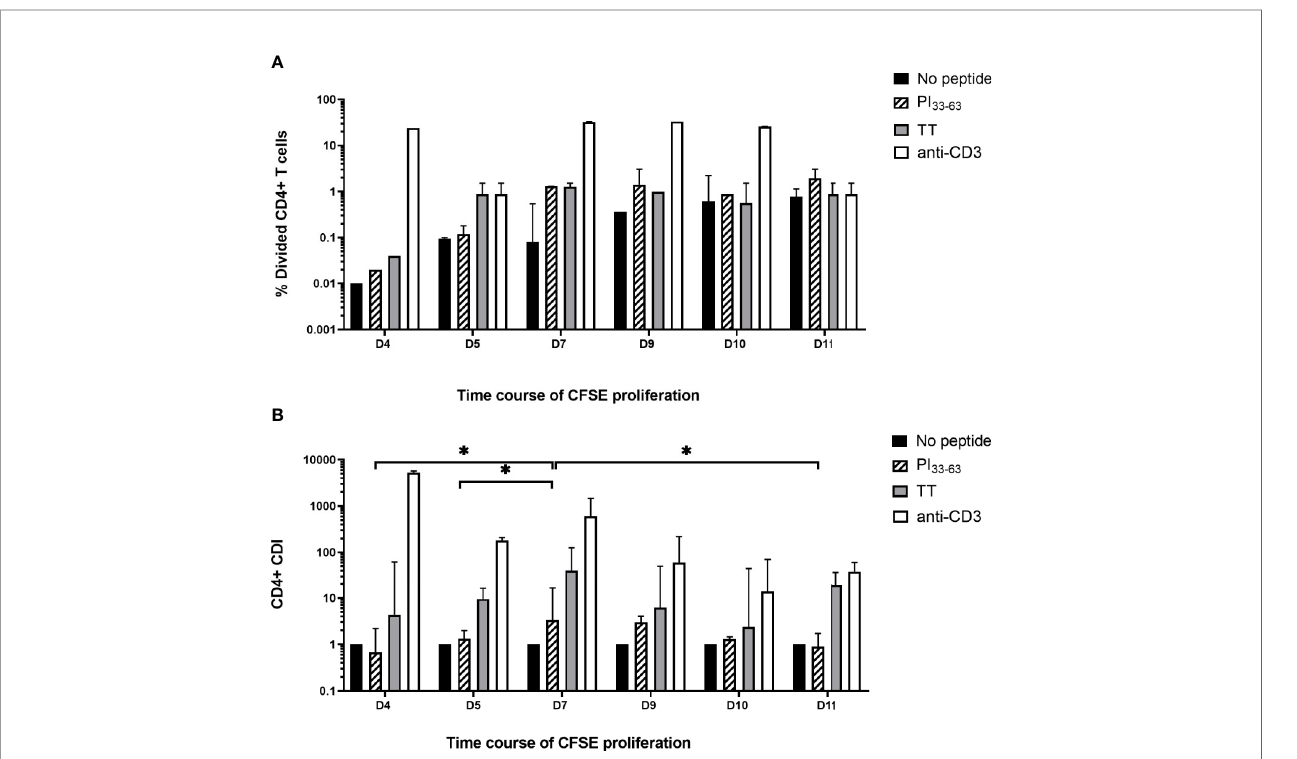
FIGURE 4 | Time course of CFSE proliferation assay. Freshly isolated PBMC labeled with CFSE 0.05 uM for 5 min were cultured with no antigen, PI 33-63 , tetanus toxoid and anti-CD3 for 4, 7, 9, 10, or 11 days and the (A) percentage of divided cells and (B) CD4 + CDI were determined. The median and IQR CDI of 5 technical replicates is shown. *p <